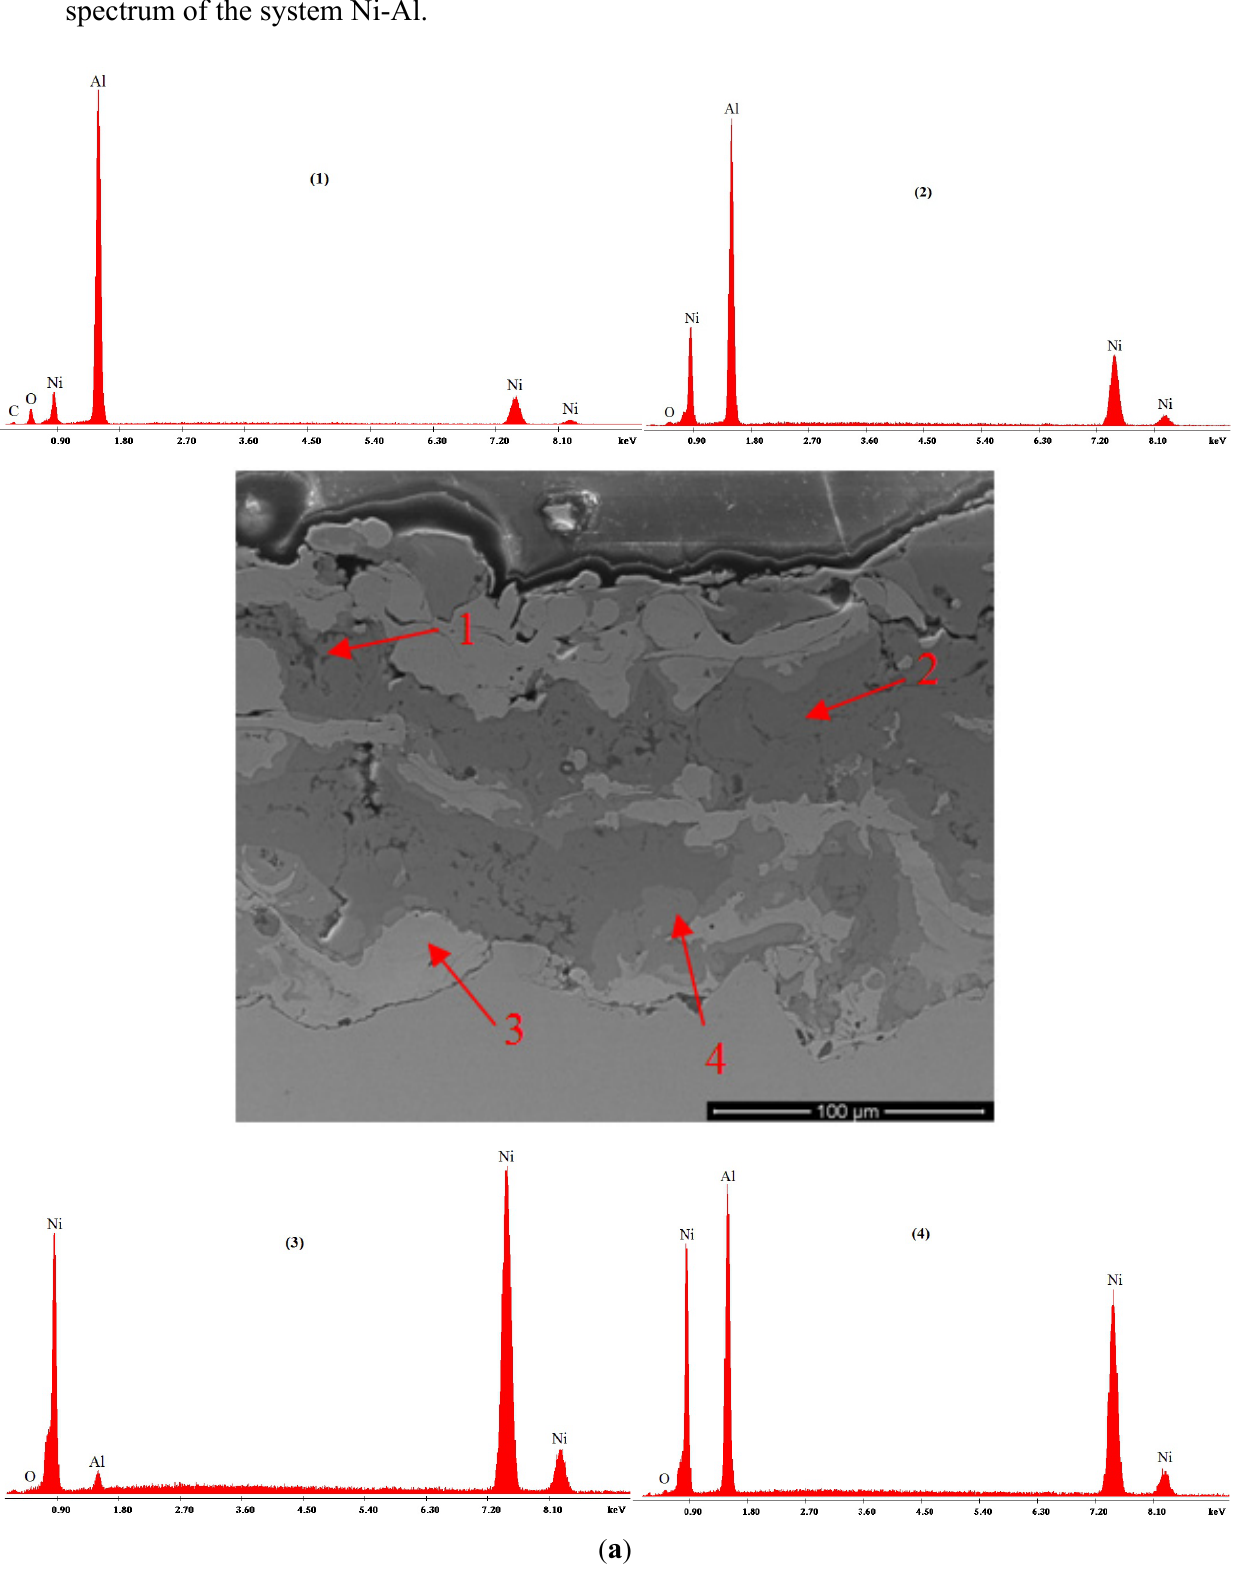
Figure 3. ( a ) SEM/EDAX microstructure analysis of cross section and ( b ) a typical XRD spectrum of the system